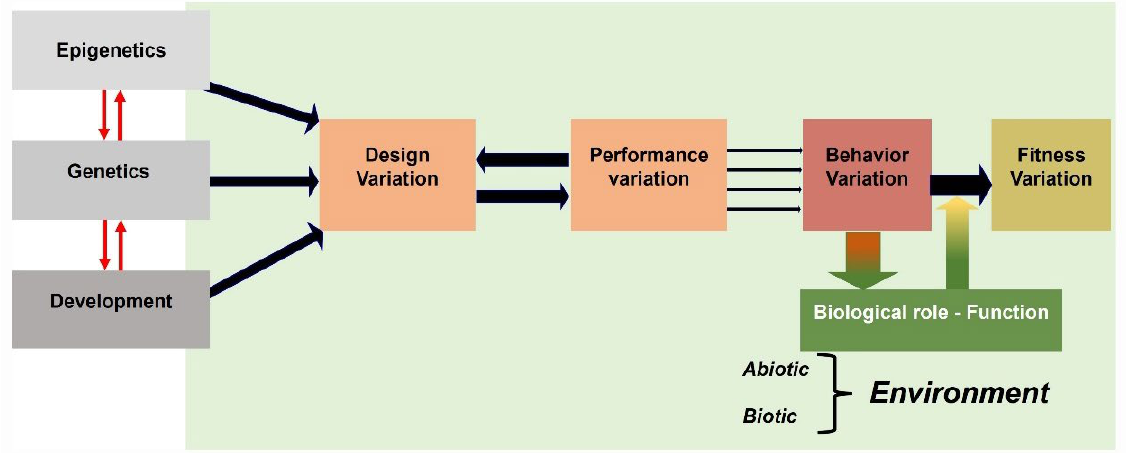
Figure 10. Illustration of an extended view of the Arnold’s paradigm [47] used in functional mor- phology, indicating the links between designs (structures), performances, behaviors, and fitness. Phenotypic traits of structures depend on complex interactions between processes relating genetics, epigenetics and development. A behavior is the result of movements of structures identified by a set of performances that reversely affect the properties of the design. Each behavior has a biological role in responding to properties of the environment